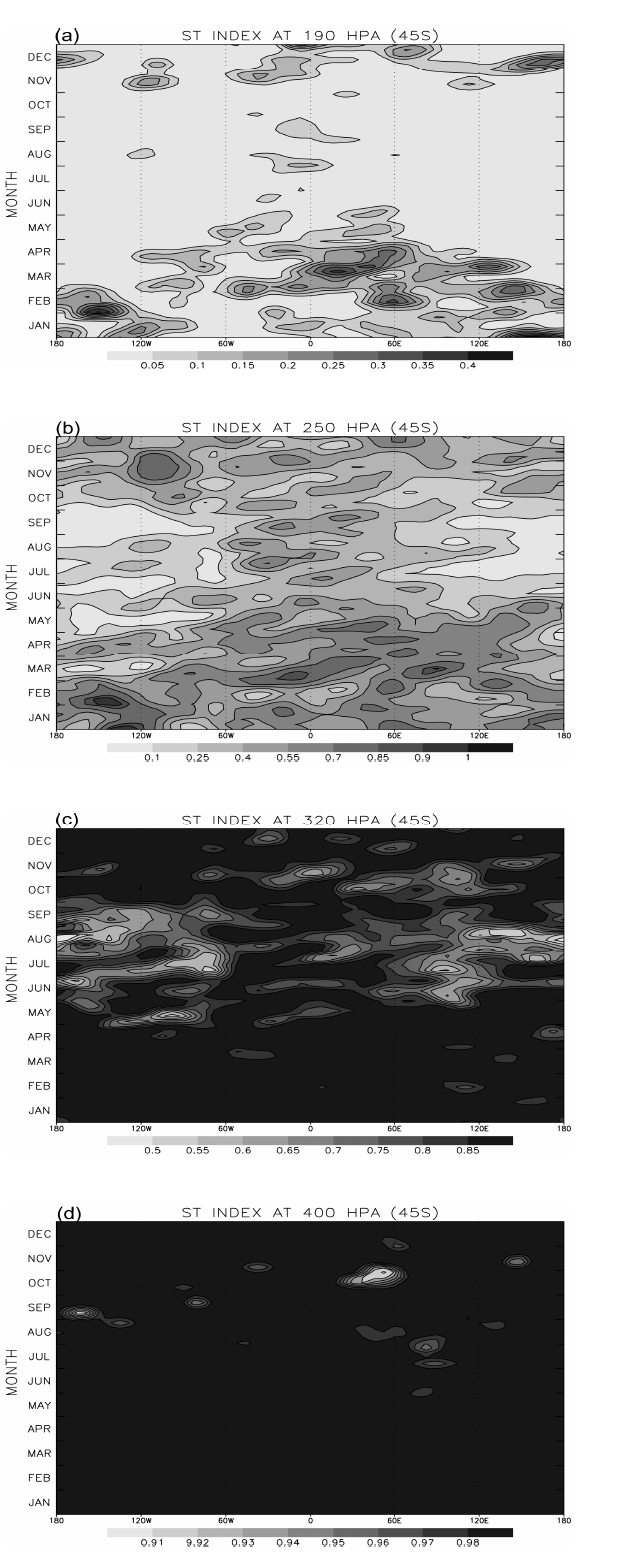
Fig. 2. Hovm¨oller diagrams of the distribution of the stratosphere- troposphere index along the 45 ◦ S latitude at (a) 190hPa, (b) 250hPa, (c) 320hPa, and (d) 400hPa surfaces.